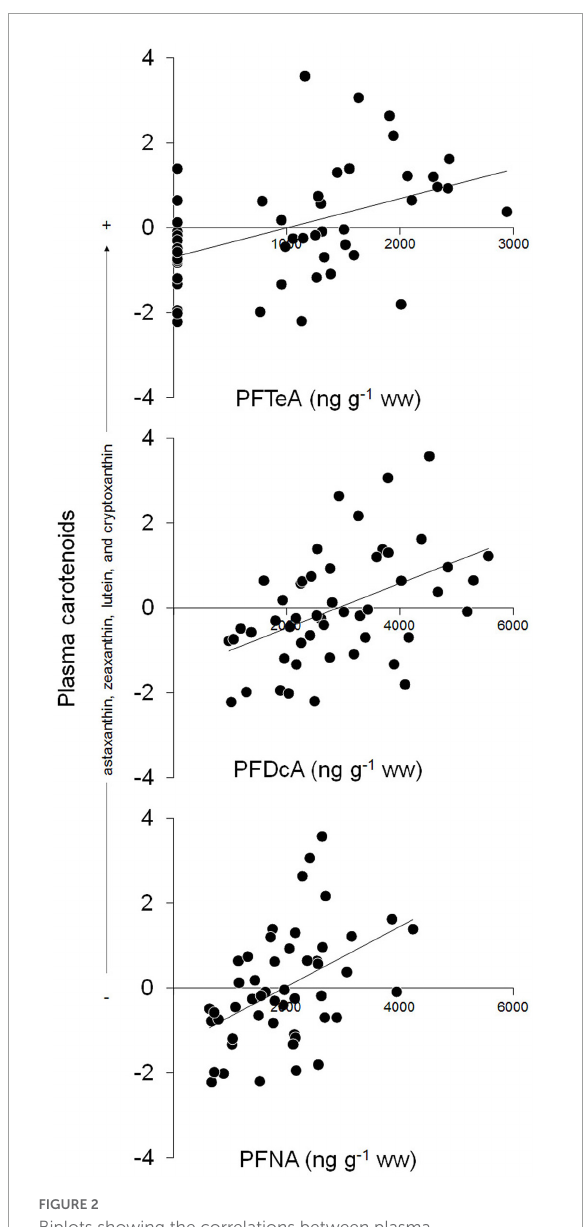
FIGURE2 Biplots showing the correlations between plasma concentrations of plasma carotenoids (PC1 from PCA) and PFTeA, PFDcA, or PFNA in 50 Arctic male kittiwakes sampled during the pre-laying